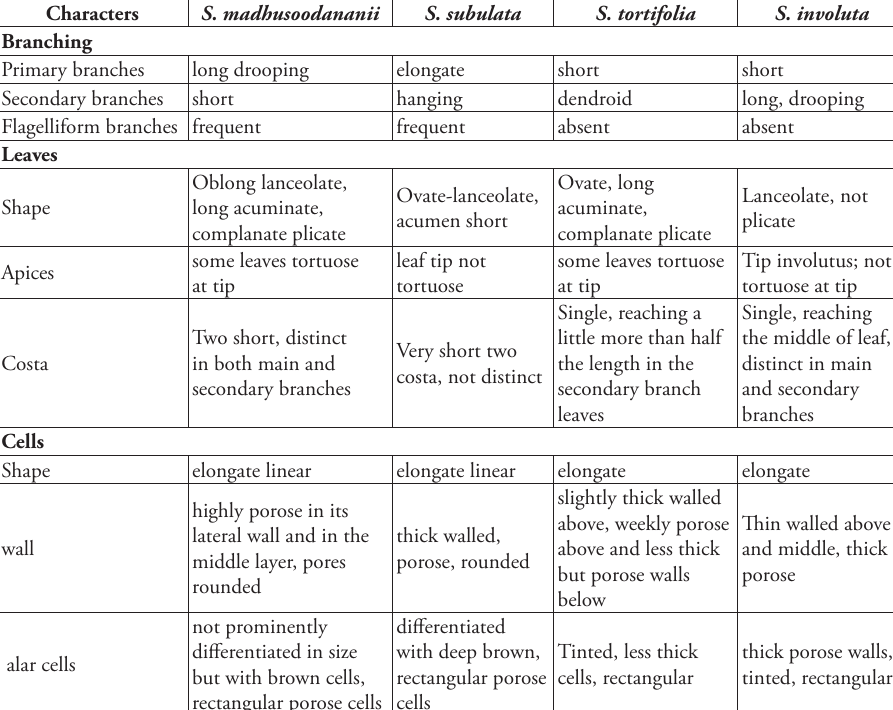
table 1. Comparison of the morphological features of Symphysodontella species in